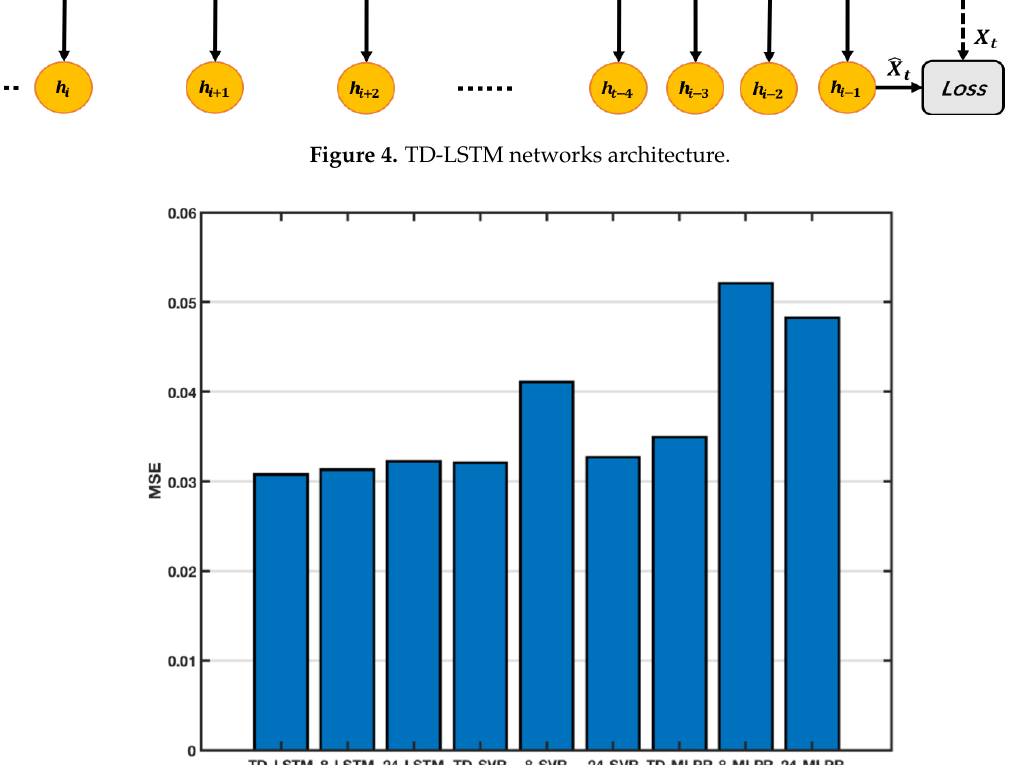
Figure 5. The average of